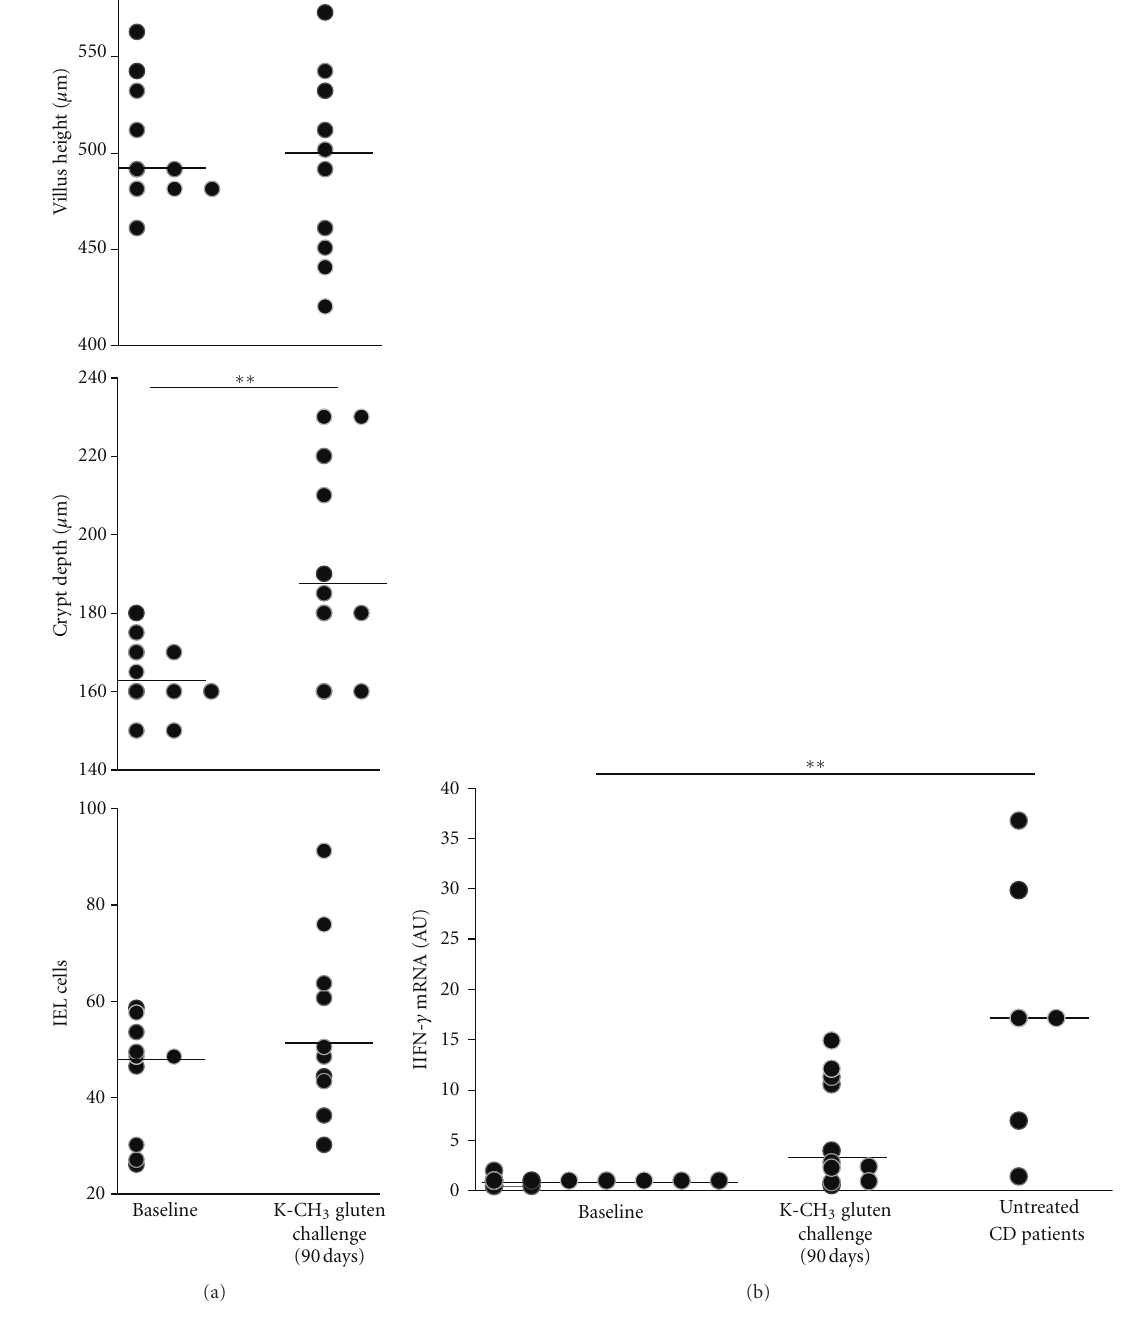
Figure 4: Assessment of intestinal mucosa following a 90-day (K-CH 3 )-transamidated gluten challenge. (a) Morphometric and immunohistochemical analyses of biopsy specimens from consenting patients (n . 10) who completed the 90-day study without developing symptoms or altered permeability; the density of CD3 + cells in the intraepithelial compartment was determined by counting the number of stained cells as a percentage of 100 enterocytes; bars indicate medians, and the statistical evaluation of data was performed using the Wilcoxon signed-rank test. (b) IFN- γ mRNA levels in intestinal biopsies from patients in the experimental group (n . 10) and from untreated CD patients (n . 6) were evaluated by real-time PCR; the cytokine values were normalized to L-32 mRNA and are presented as fold change in gene expression (AU); bars indicate medians, and the Kruskal-Wallis statistic and Dunn’s Multiple Comparison test were used to compare di ff erences among groups (1) ∗ : P < 0 . 05; ∗∗ : P < 0 .